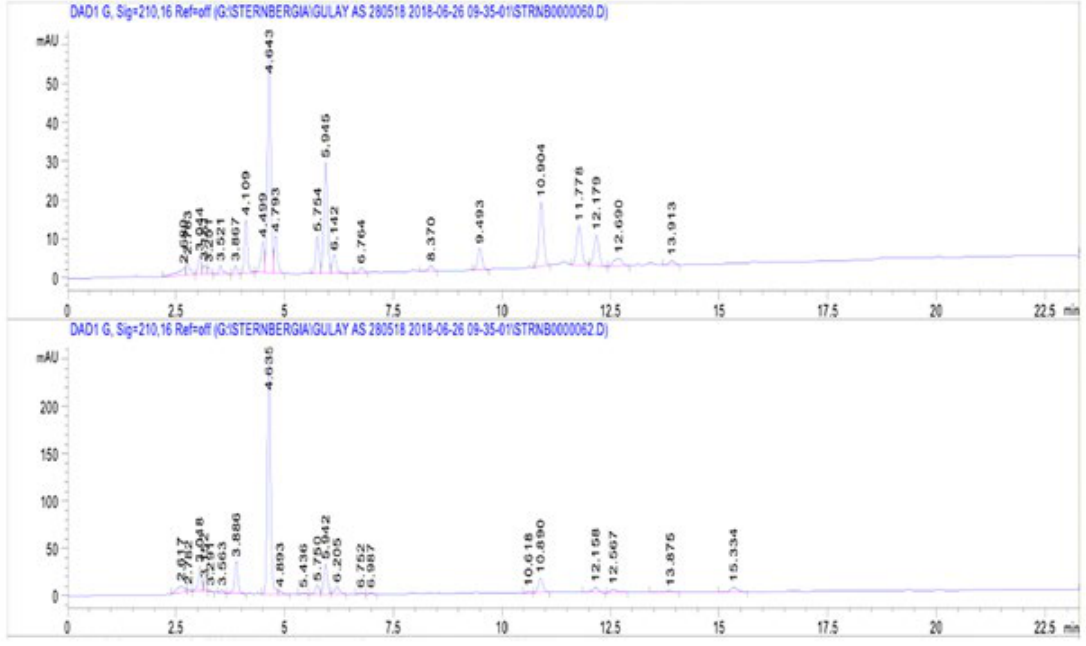
FIGURE 5 - HPLC chromatogram of S. vernalis (a), S. lutea (b).